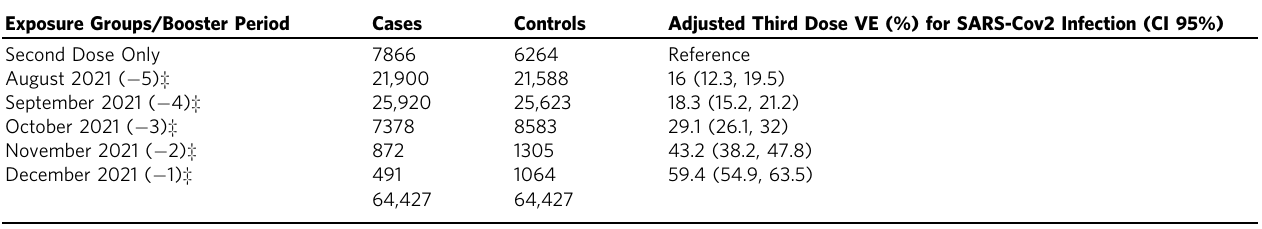
Table 3 Additional analysis; adjusted Third Dose Effectiveness (VE) against SARS-Cov2 infection, compared to second-dose only